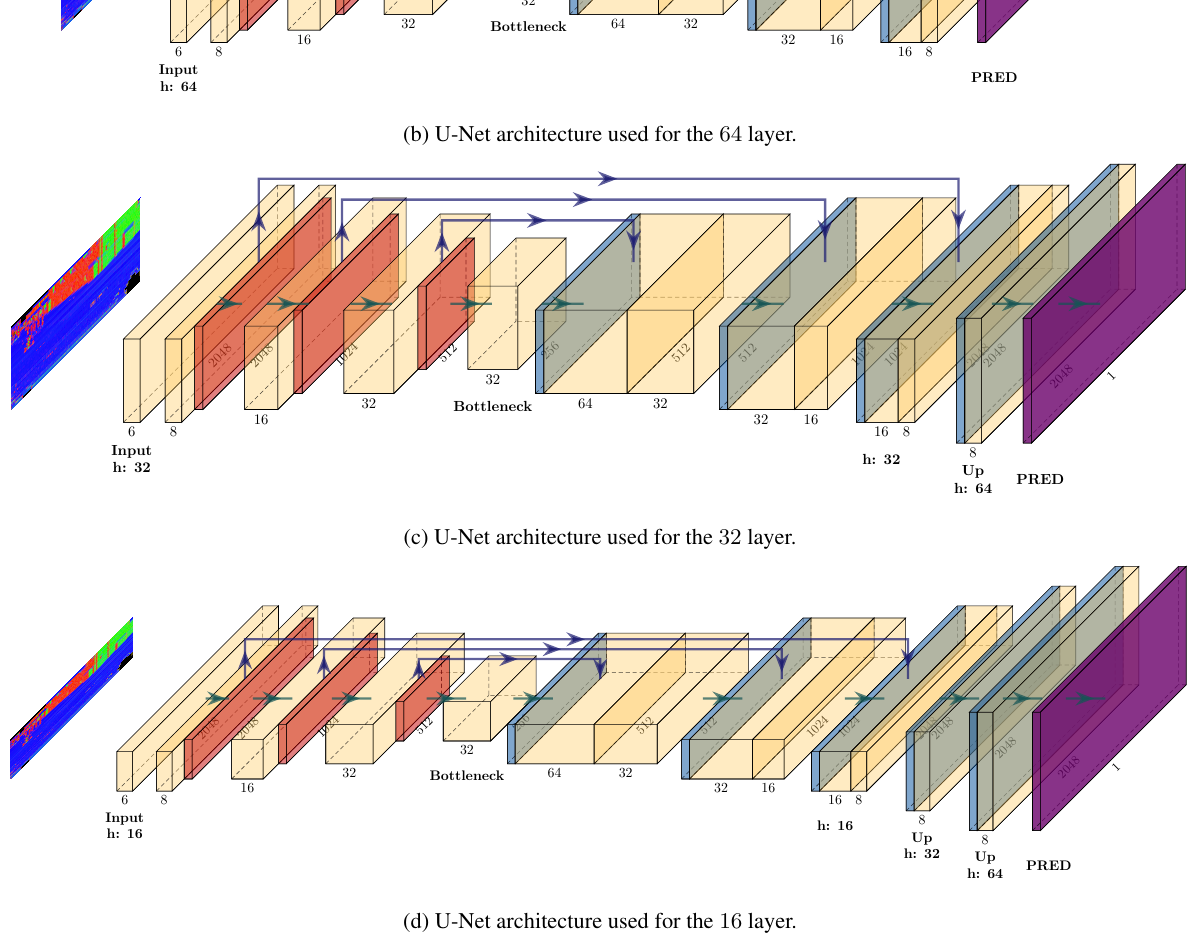
Figure 3. (a) LoDNN Architecture used on BEV images. (b-d) U-Net Architectures used on SV